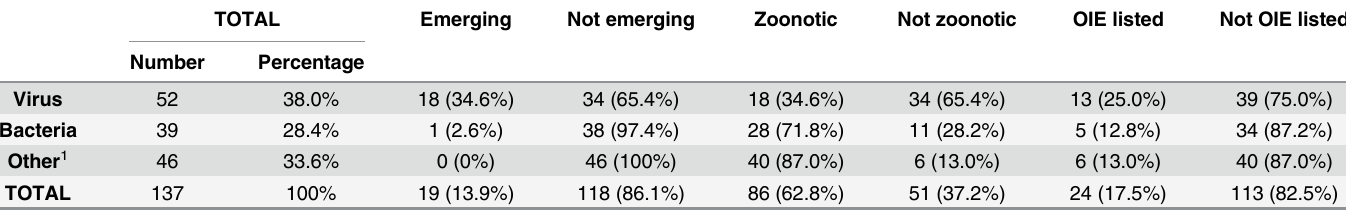
Table 1. Distribution of pathogens. Taxonomic divisions (number and percentage) of infectious agents used in the study and whether they cause an emerging (less than 20 years from first description in pig) or non-emerging associated diseases, with zoonotic potential or as OIE-listed disease (2015) according to sources described in “ Selection and grouping of pathogens ”